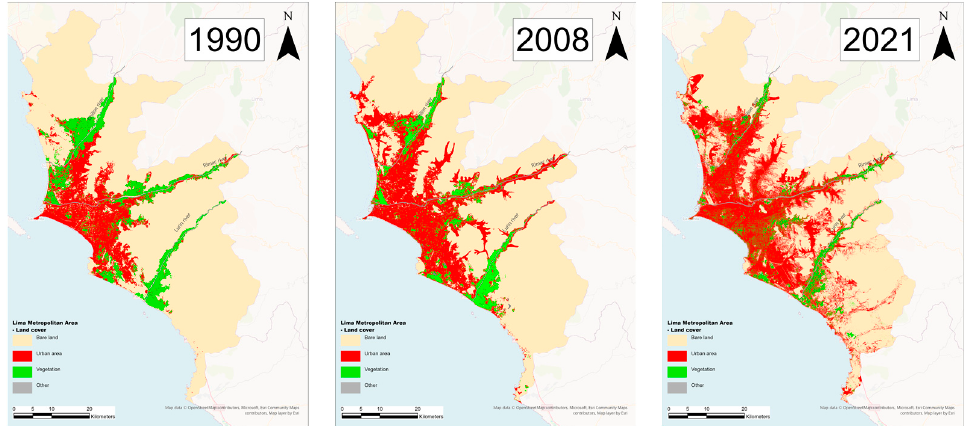
Figure 3. Land cover changes in Lima Metropolitan Area for the years 1990, 2008 and 2021. In overall, the urban areas of the five LMA zones shifted during the study period. Nonetheless, Lima Center (LC) was the only zone displaying a negative sprawl ( − 14.25%). Figure 4 displays the urban sprawl per period and zone. It is noticeable that the areas further west of LMA (Callao and Center) were almost completely covered by urban set- tlements by 1990. Although Lima North (LN), South (LS) and East expanded considerably and even more than Lima Center, it is detectable that there are other dominant covers in these zones. The land cover of these areas may potentially shift in the coming years. LN more than doubled the urban areas (+105.45%). Following the trend, LS almost quadru- pled the area of settlements (+256.16). Callao and Lima East also experienced a signifi- cantly high urban sprawl, corresponding to +66.19% and +76.98%, respectively.